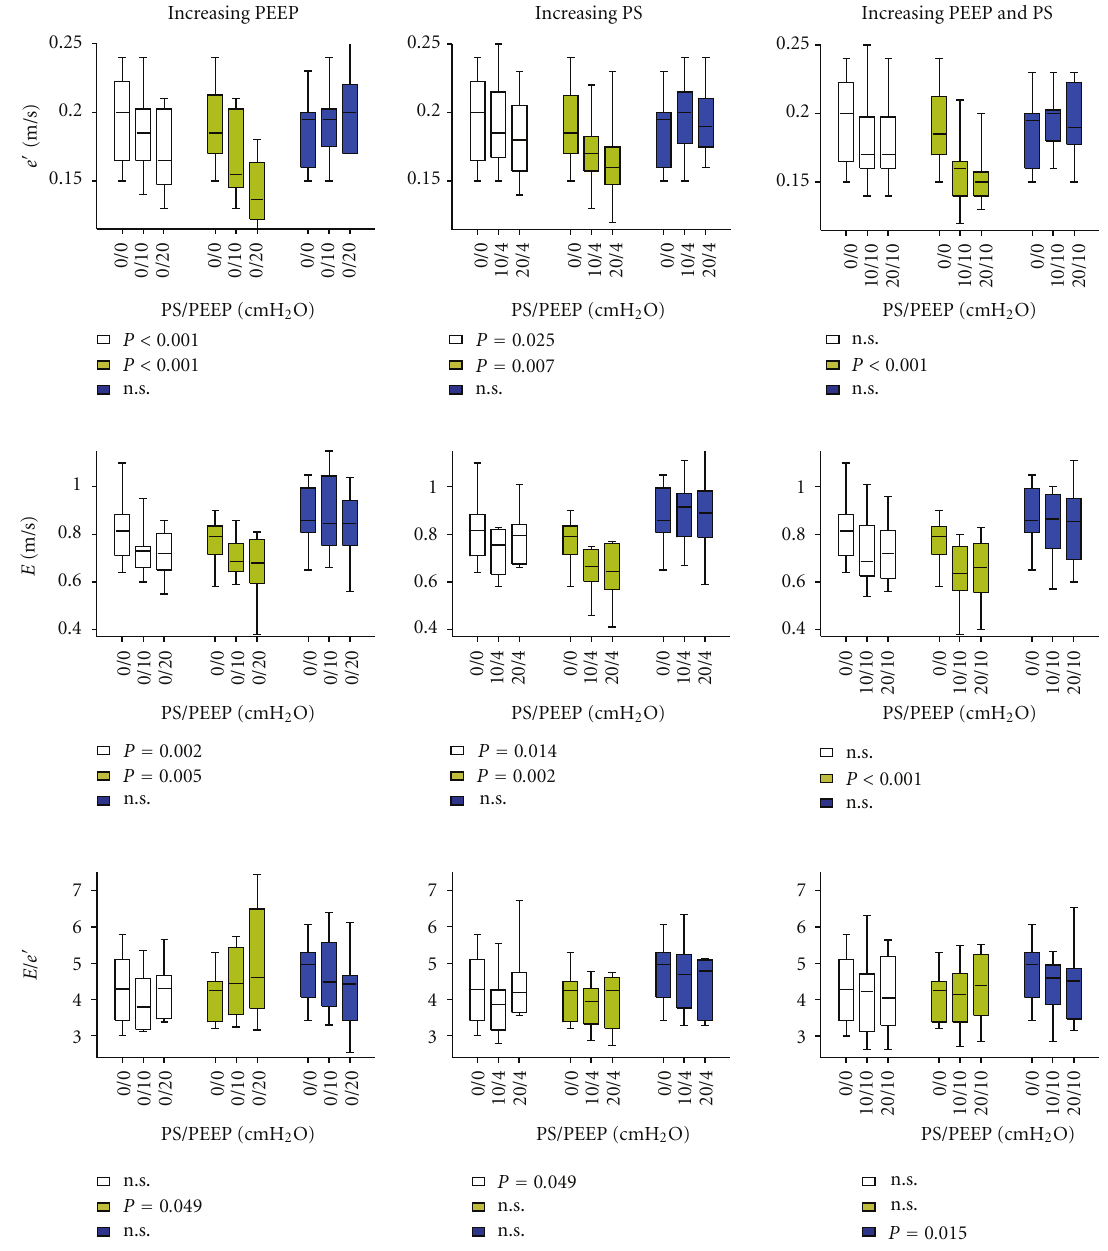
Figure 3: The influence of varying levels of positive pressure ventilation on diastolic echocardiographic indices. E ff ects of selective increases in either positive end-expiratory pressure (PEEP), pressure support (PS), or combinations of PEEP and PS on e (cid:2) , E and the composite ratio, E/e (cid:2) , in varying positions. P values reflect no influence of ventilator settings. n.s.: Not significant. Data are presented as median, interquartile range (box) and range (whiskers). Empty square: Horizontal position, yellow colored square: reverse-Trendelenburg position, blue colored square: Trendelenburg